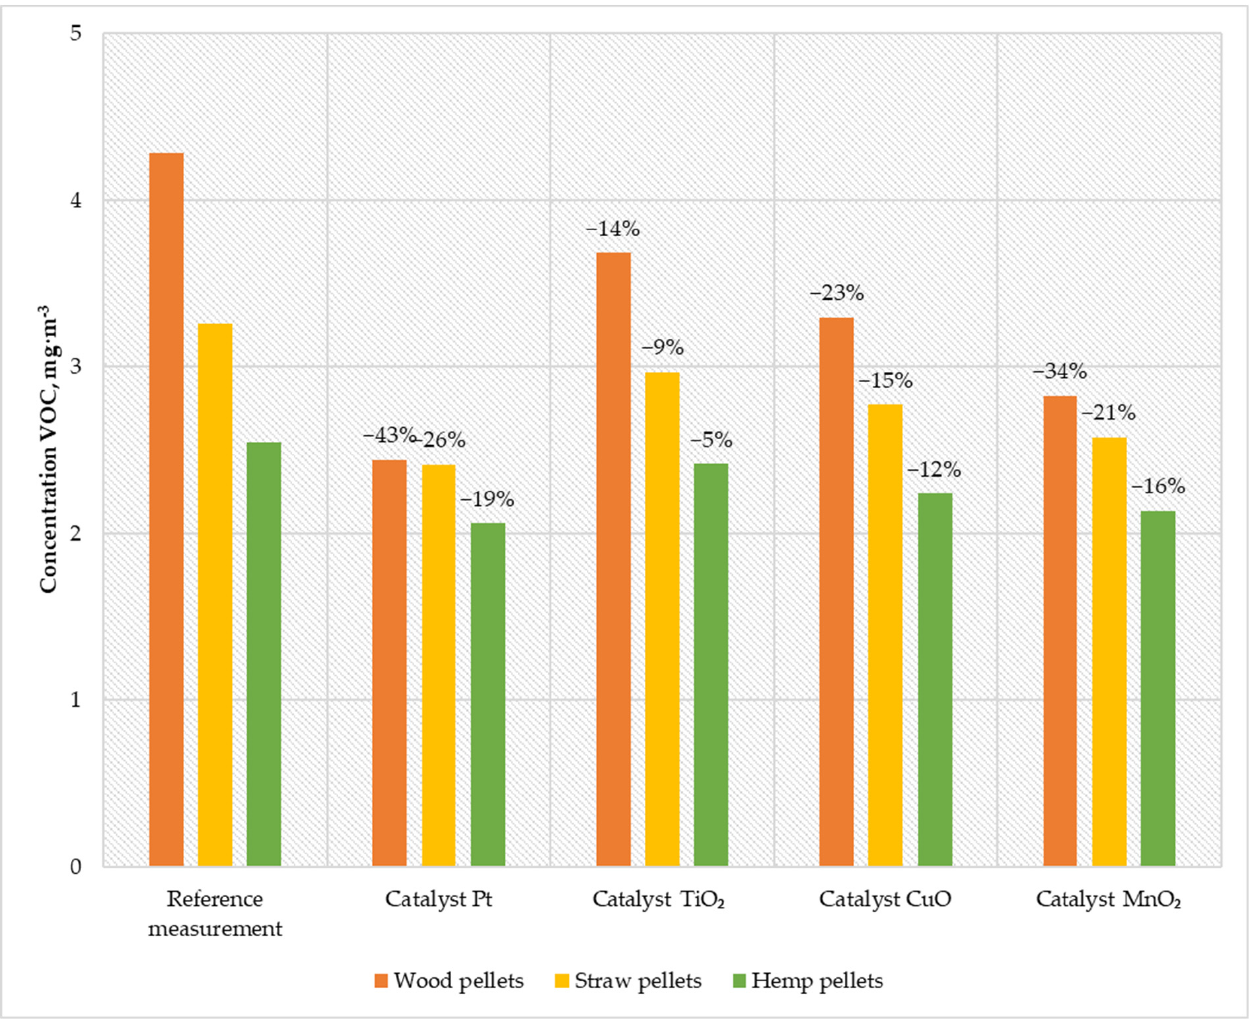
Figure 9. Average VOC content in the flue gas from a low-power biomass boiler.